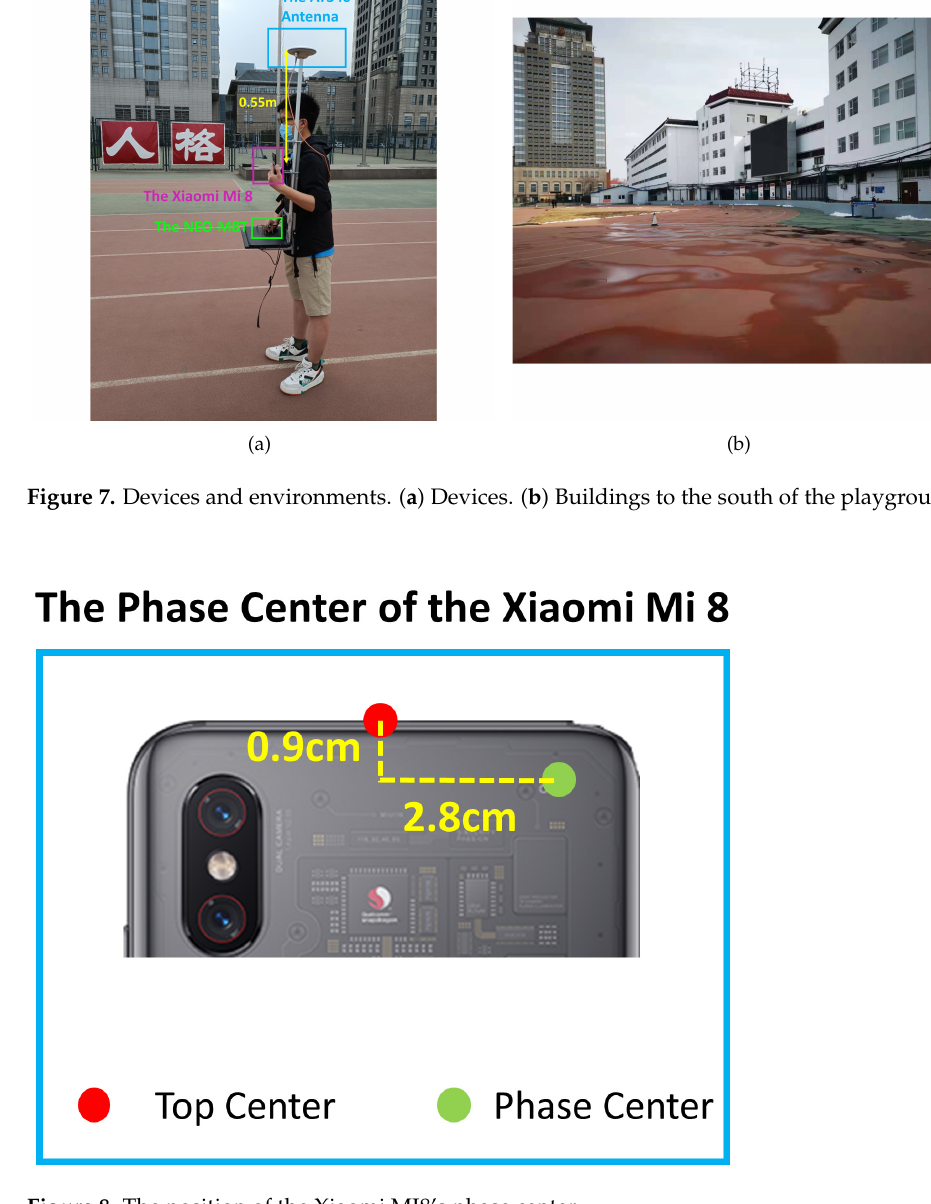
Figure 8. The position of the Xiaomi MI8’s phase